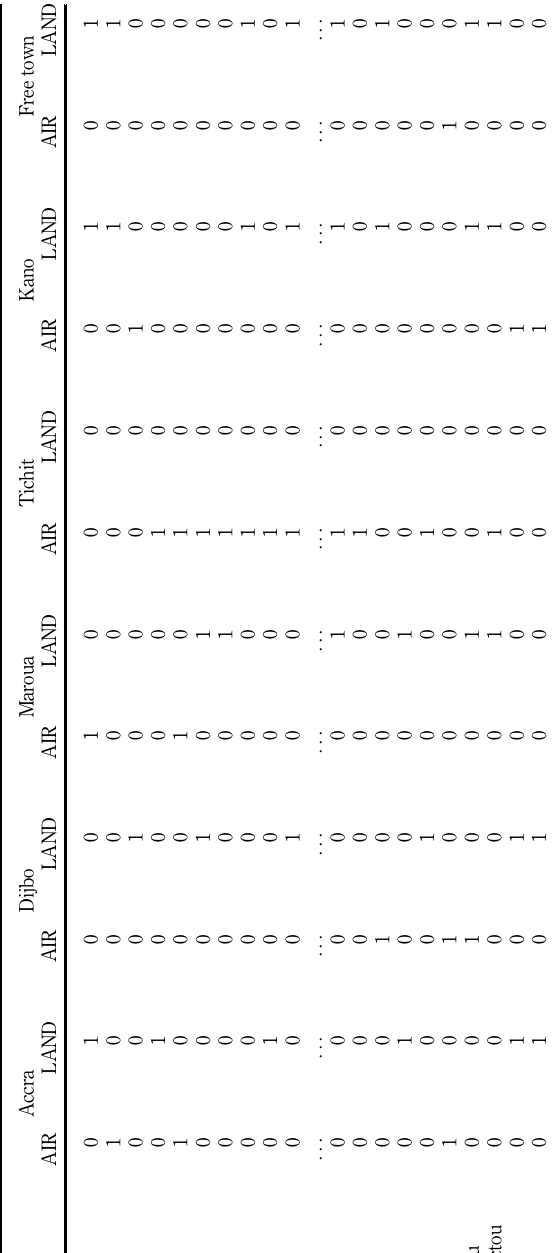
Table 8. Suggested connections between transshipment hubs (top row), a representative subset of 20 of the 61 demand sites (first column) and A 1 in a cell indicates a suggested connection between a transshipment hub and a demand site by